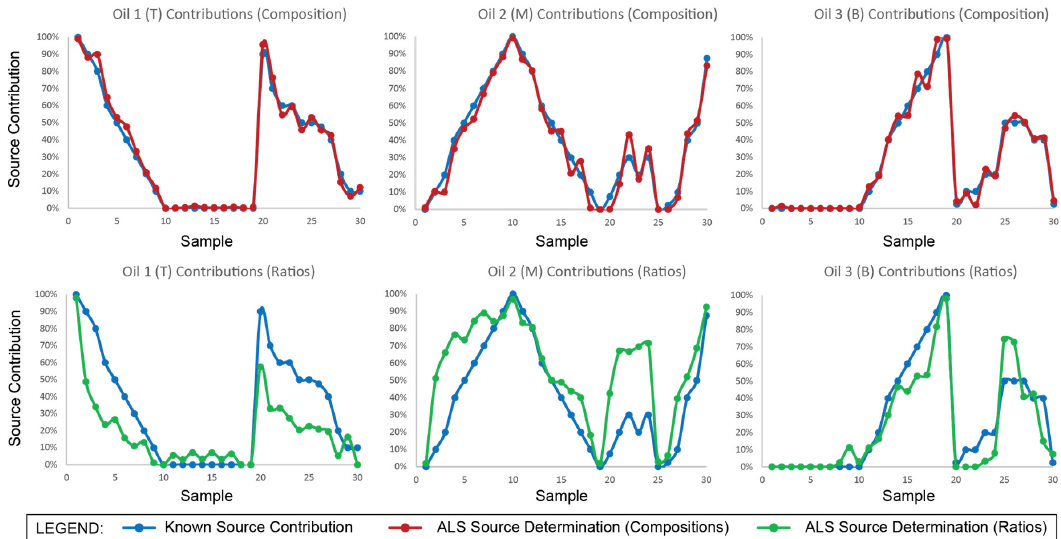
Figure 2. Source Contribution results for artificially mixed samples in the laboratory. The top three graphs are the individual oil samples and their known contributions ( blue ) compared with the calculated contributions from compositional data ( red ). The bottom three graphs are the same individual oil sample contributions comparing known contributions ( blue ) to the calculated contributions from ratio data ( green ). The curvature and offset in the ratio data is evident across all three contributing samples. The full comparative results are shown in Table 1.